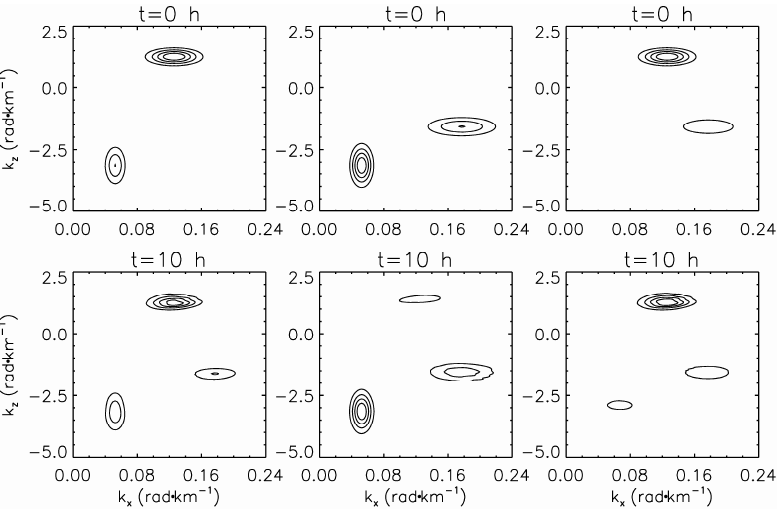
Figure 8. Similar to Fig. 2, but for cases 7-9.